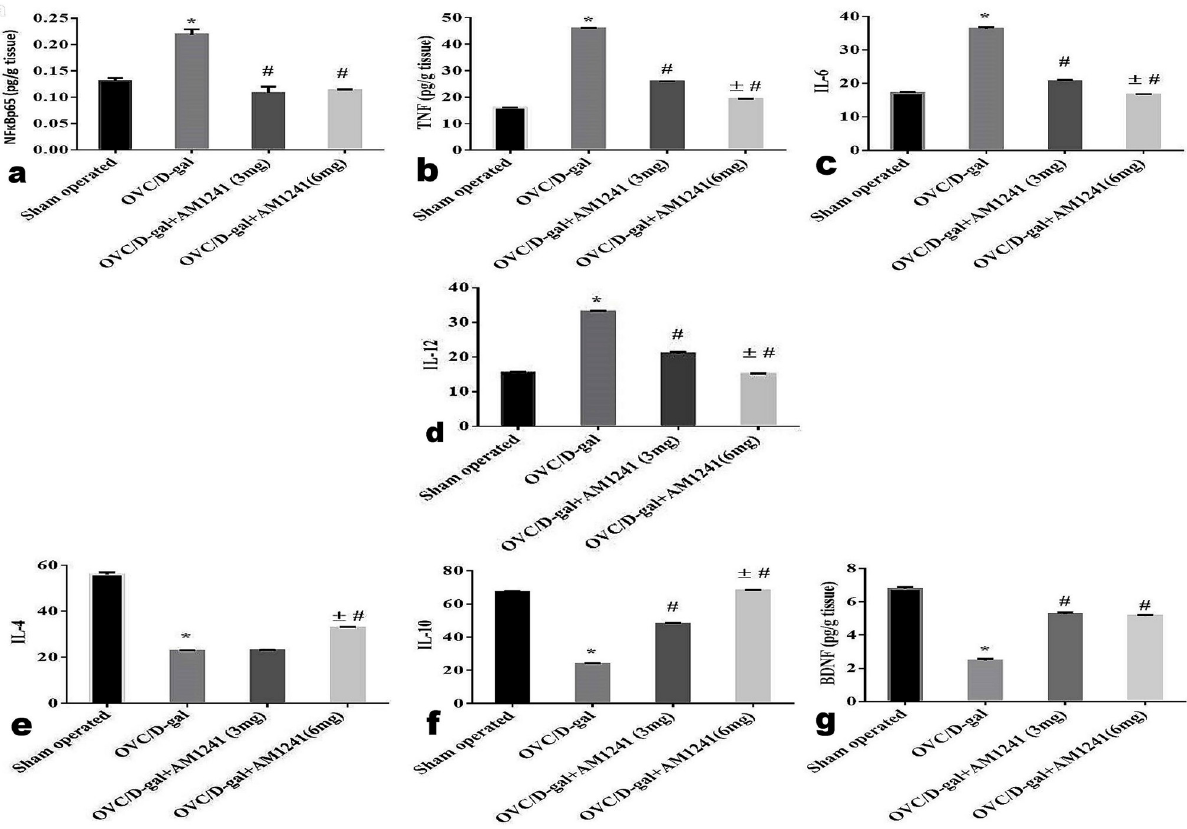
Fig 3. Effect of AM1241 on pro-inflammatory; NF κ B p65, TNF- α , IL-6 and IL-12, immune-modulatory; IL-4 and IL-10 levels as well as the neurotrophic factor; BDNF in hippocampal tissue homogenate of OVC/D-gal rats. Data were analyzed by using one way ANOVA followed by Tukey’s post hoc test. Values expressed as mean ± SE (n = 15 rats/group). � , #, and ± statistically significant different at P < 0.05, where; � statistically significant different comparing with control group, # statistically significant different comparing with OVC/D-gal group, ± statistically significant different comparing with AM1241